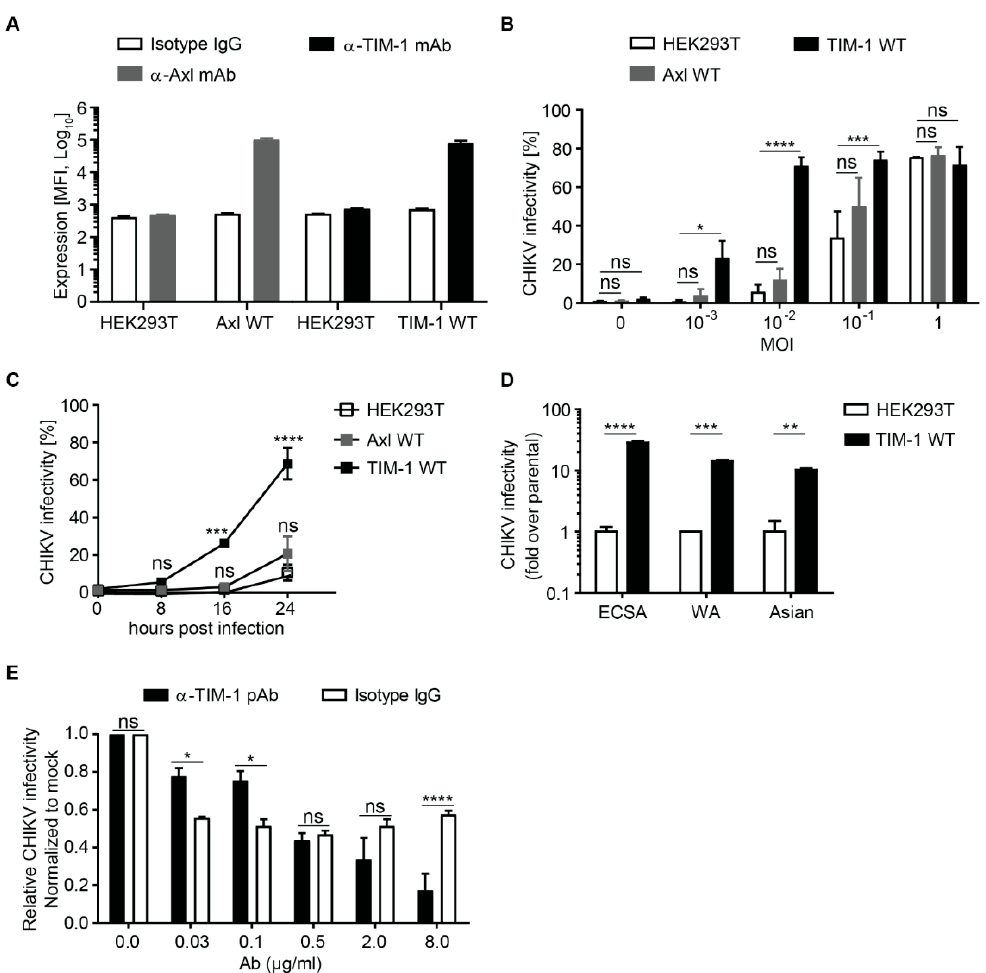
Figure 1. Ectopic expression of TIM-1 enhances CHIKV infection ( A ) Surface expression of Axl and TIM-1 wild type (WT) proteins on parental HEK293T and stably transduced cells was evaluated by monoclonal antibody staining and flow cytometry. Cells stained with an isotype IgG were used as control. ( B ) Parental, Axl WT and TIM-1 WT expressing cells were challenged with ECSA 3 ′ GFP-CHIKV at indicated MOI and ( C ) for different infection durations at MOI of 0.01. Infection levels were assessed by flow cytometry and plotted as percentage of GFP positive cells. ( D ) Parental and TIM-1 WT expressing cells were challenged with CHIKV strains of ECSA 3 ′ GFP-CHIKV (MOI = 0.01), WA 5 ′ GFP-CHIKV (MOI = 0.01) and Asian mc-CHIKV (MOI = 0.1) genotypes and infection assessed by flow cytometry. ( E ) HEK293T cells expressing TIM-1 were pre-incubated for 30 min with increasing concentrations of TIM-1 polyclonal antibody (black bars) or isotype control antibody (mock, white bars) before inoculation with ECSA 3 ′ GFP-CHIKV at MOI of 0.01. After 4 h the cells were washed and infection levels analyzed by flow cytometry 20 h later as in ( B ) and ( C ). Error bars represent standard error of the mean (SEM) of three biological replicates. Statistical significance was calculated using a Dunnet’s multiple comparisons test (2way ANOVA) ns > 0.05, * p < 0.05, ** p < 0.01, *** p < 0.001 and **** p < 0.0001.